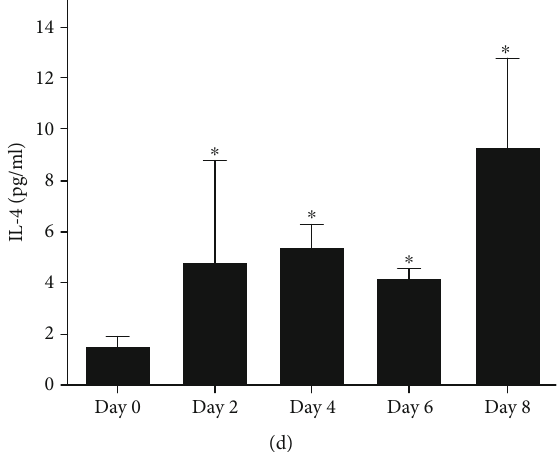
Figure 2: IL-4 promotes myogenesis by up-regulating expression of myocyte-speci fi c marker. (a) Levels of myogenin, MYF6, CDK5 and MyHC protein expression at the time indicated were analyzed. (b) Morphology of C2C12 cells at the indicated day. (c) Cell lysates were harvested at the time indicated and IL-4R and GATA3 was analyzed (n =3). ∗ p < 0 : 05 and ∗∗ p < 0 : 01 v.s control at day 0, # p < 0.05 v.s IL-4 at day 0, ∫ p < 0.05 v.s control at the same day. (d) IL-4 in culture medium harvested at the day indicated was measured by ELISA. ∗ p < 0 : 05 v.s control at day